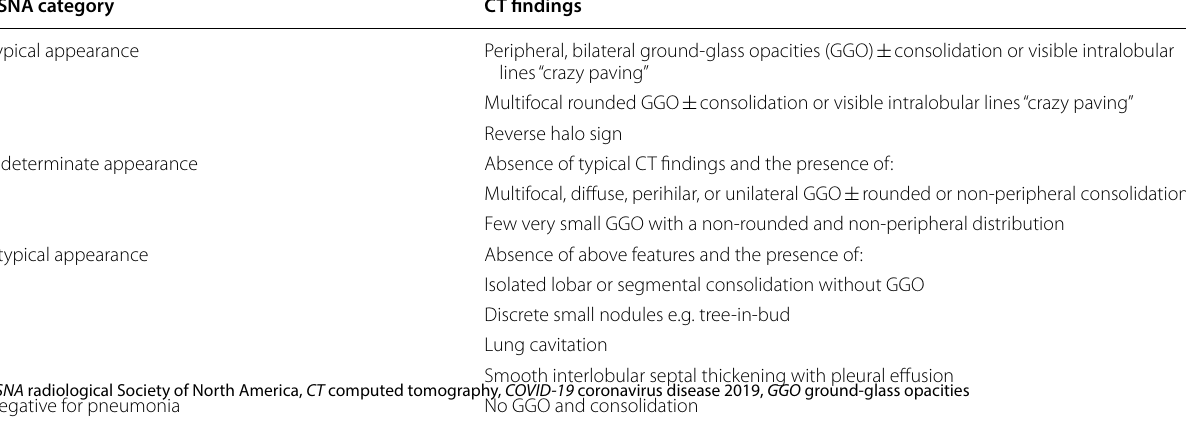
Table 2 RSNA chest CT classification system related to